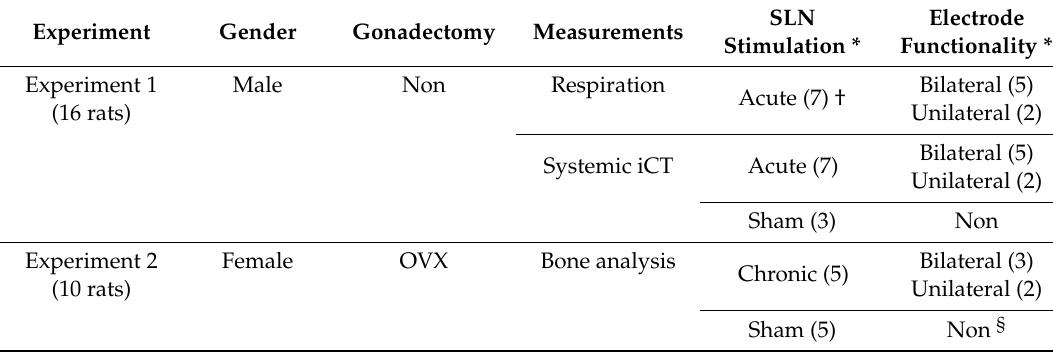
Table 1. Summary of the two experimental